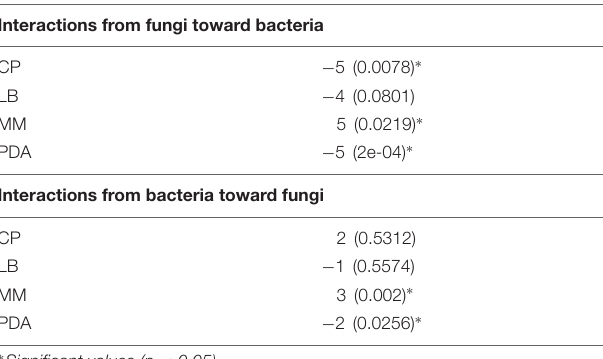
TABLE 2 | Exact Wilcoxon Sum Rank test results, where values are medians of all interactions on the network, p-values are given in parentheses. Interactions from fungi toward bacteria